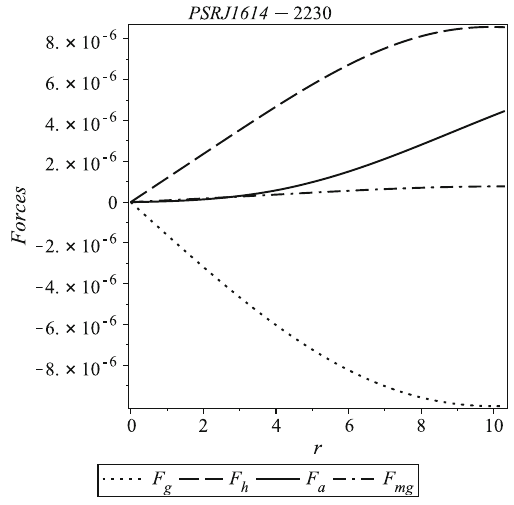
Fig. 6 Variation of different forces w.r.t. the radial coordinate r for the strange star candidate PSRJ 1614–2230